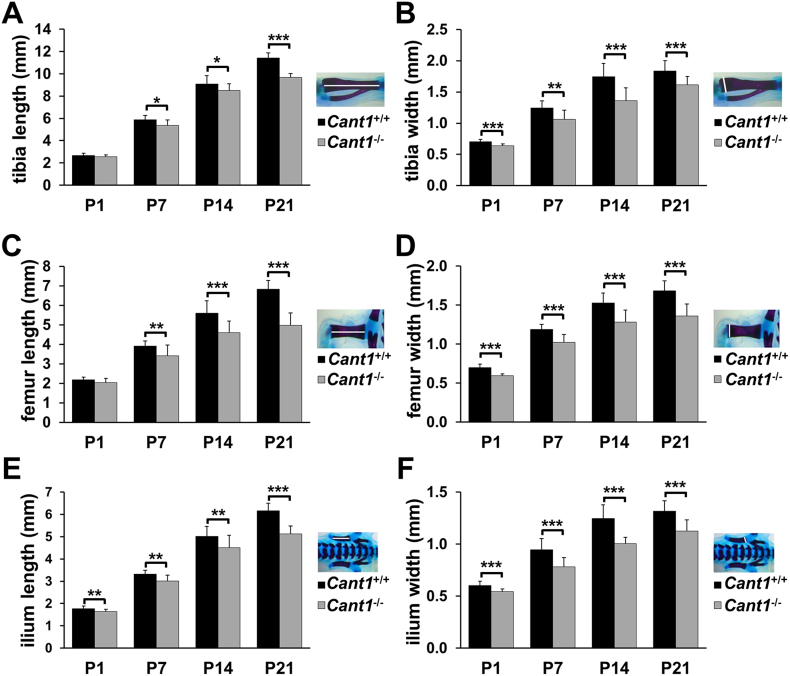
Endochondral ossification is affected in Cant1−/− mice. (A – F) Morphometric analysis of alcian blue and alizarin red skeletal preparations. (A) Tibia length was significantly decreased in Cant1−/− mice starting from one week of life (P7), whilst (B) tibia width was reduced from birth. Similar changes were observed in (C, D) the femur, whereas (E) both the ilium length and (F) width were significantly decreased in Cant1−/− mice from birth. Data are presented as mean ± SD, significance was determined by Student's t-test, * P < 0.05; ** P < 0.01; *** P < 0.001; n = 5.